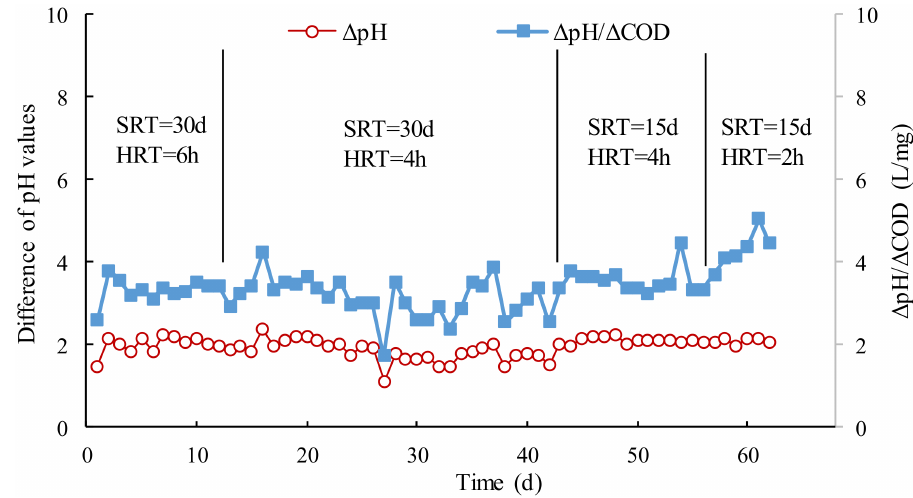
Figure 4. Effect of SRT and HRT on variation of pH values per unit COD ( ∆ pH/ ∆ COD).